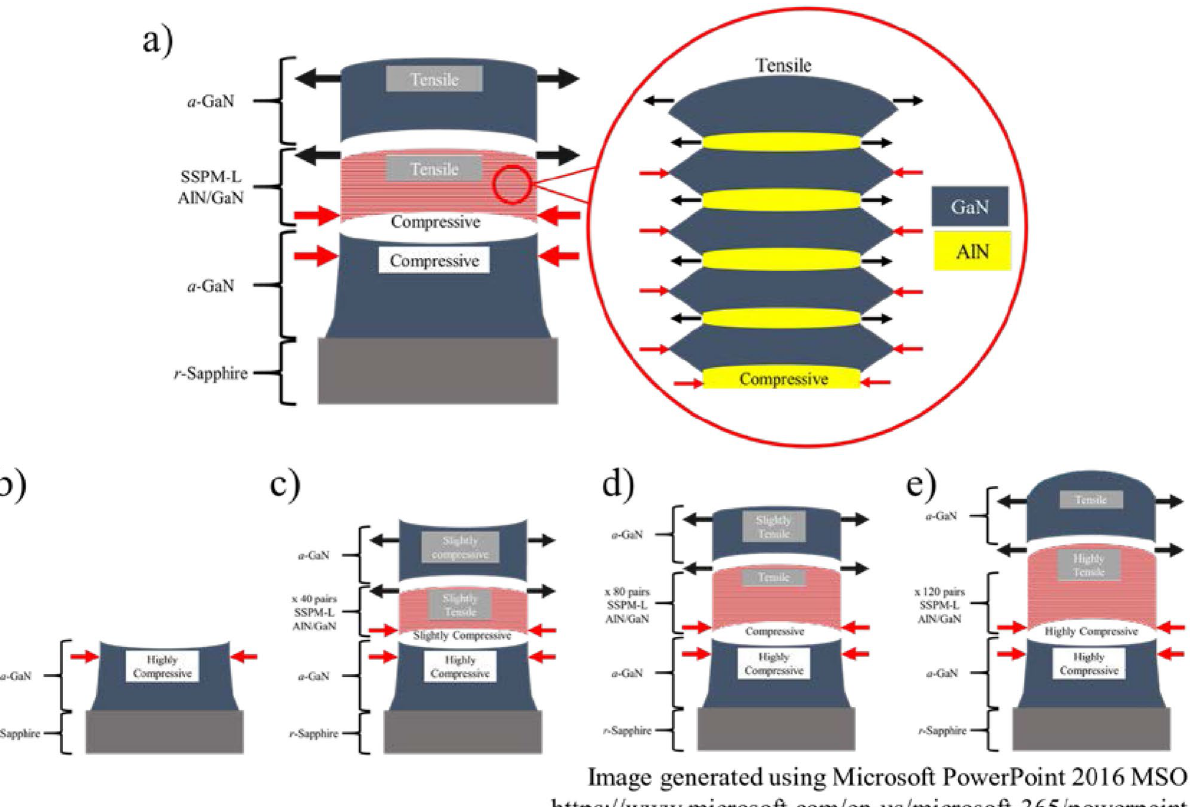
Figure 9. ( a ) Schematic of a -GaN growth on r -plane sapphire using SSPM-L AlN/GaN and schematized strain growth in samples ( b ) S1, ( c ) S2, ( d ) S3 and ( e )